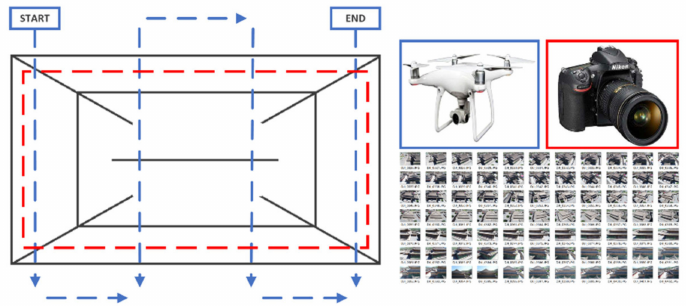
Figure 9. Airline and route design of the data